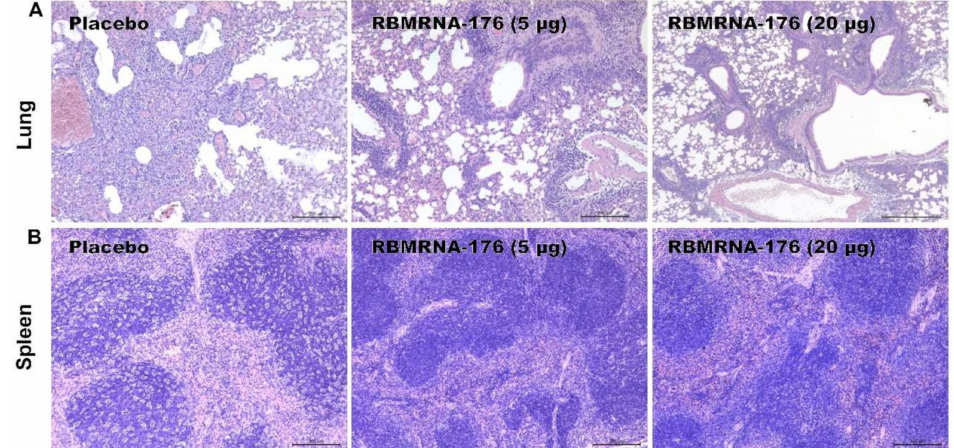
Figure 6. Histopathological changes in lungs and spleens in mice challenged with SARS-CoV-2. RBMRNA-176-vaccinated mice were intranasally challenged with 5 × 10 4 PFU of SARS-CoV-2. At 5 dpi, lungs ( A ) and spleens ( B ) were collected for hematoxylin and eosin (H&E) staining and examination of histopathologic changes ( n = 4; original magnification: 100 × ; scale bar: 200 µ